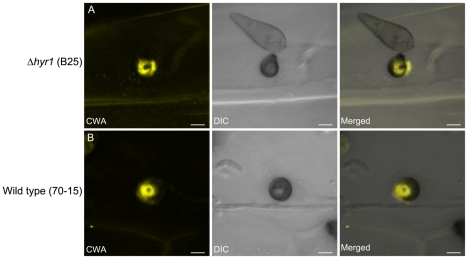
Putative plant-generated cell wall appositions surround the
penetration sites 40 hpi.Confocal 3-D maximum intensity projections of aniline blue stained
infected leaves showed cell wall appositions. (A) A
representative cell wall apposition (yellow) shown here was detected in
barley 40 hpi with Δhyr1 (B25) mutant conidia.
(B) Comparable cell wall appositions (yellow) were also
detected in barley 40 hpi after inoculation with wild type (70-15).
Transmitted light images were merged with 3-D confocal data to aid in
visualization of plant and fungal structures. Scale bars
 = 5 µm.